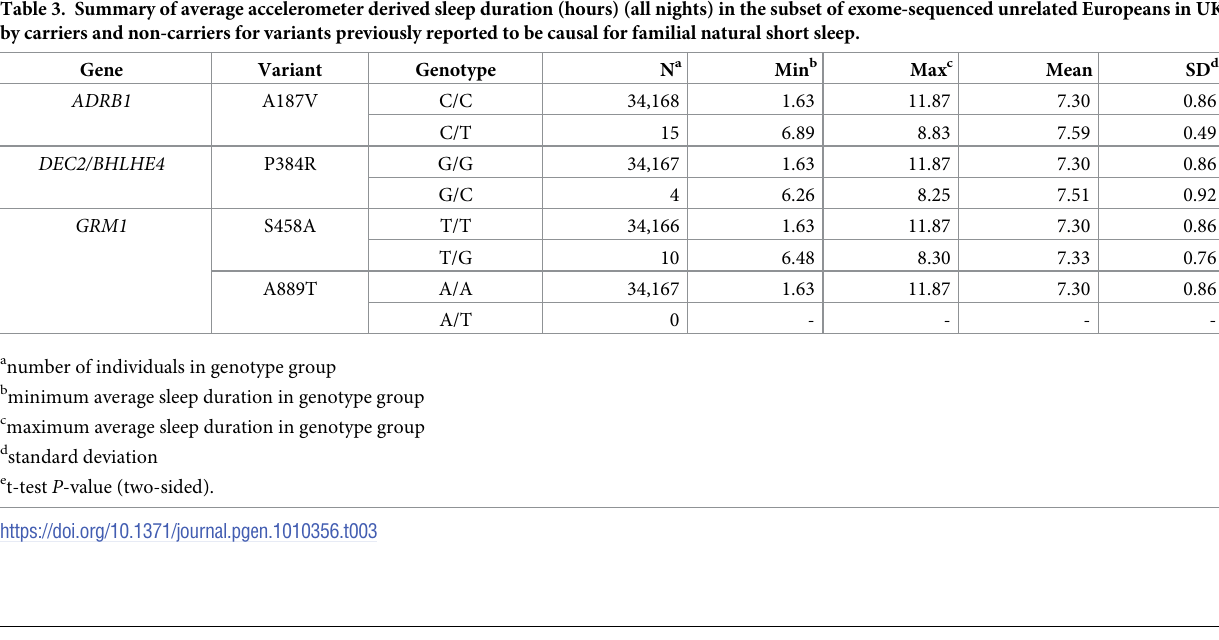
Table 3. Summary of average accelerometer derived sleep duration (hours) (all nights) in the subset of exome-sequenced unrelated Europeans in UK Biobank, split by carriers and non-carriers for variants previously reported to be causal for familial natural short sleep. Gene Variant